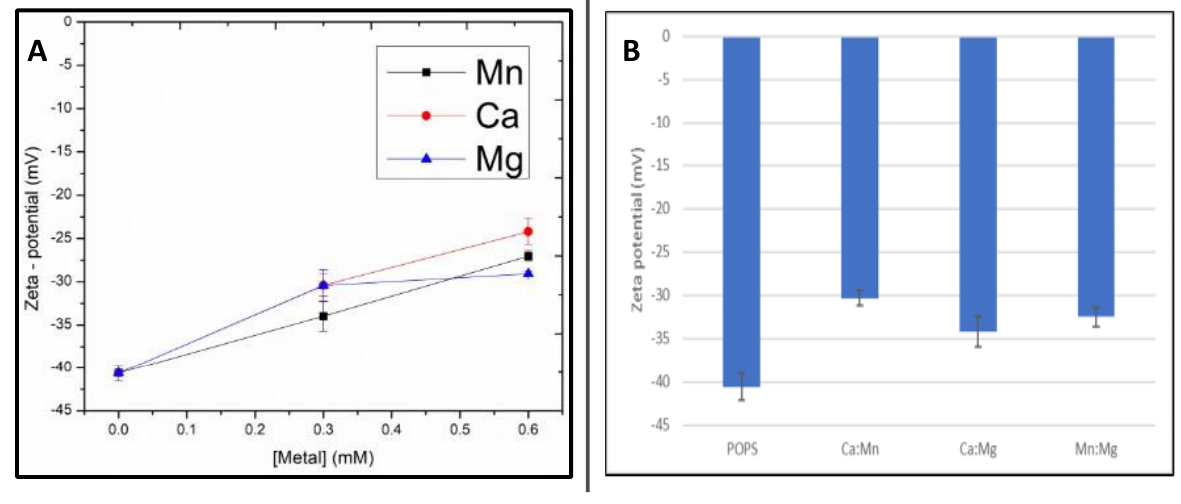
Figure 4. Zeta potential values of POPS LUVs with ( A ) mixtures of Mn, Ca and Mg present in a 1:1 metal mixture to a total metal concentration of 0.3 mM and ( B ) dose-dependent additions of Mn, Ca and Mg. Samples were measured at 25 °C Data are obtained as an average of three replicates ± standard deviation ( n = 3).